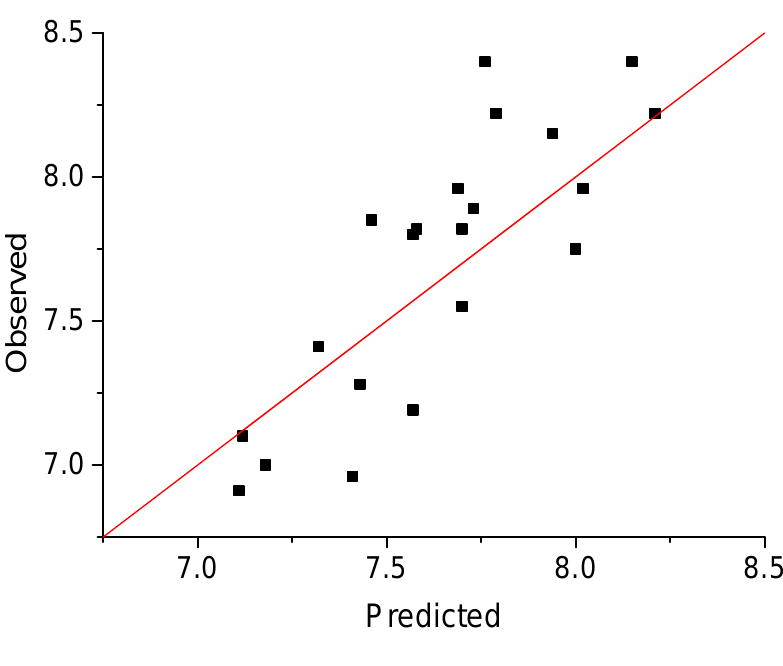
Figure 4. Observed versus predicted activities in the training